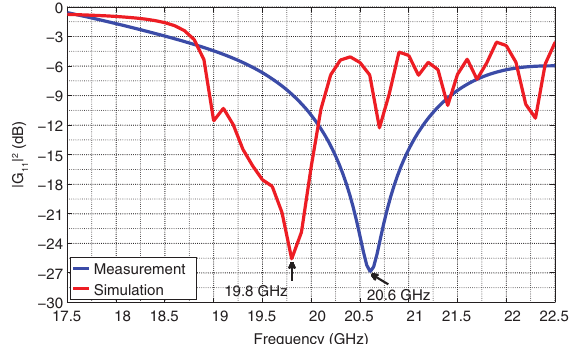
Figure 11: Measured specular reflections of a fabricated reflection- less bianisotropic metasurface for 0 ° to 71.8 ° refraction at a fre- quency band around 20 GHz via a quasi-optical measurement setup. Obtained from Ref. [60].